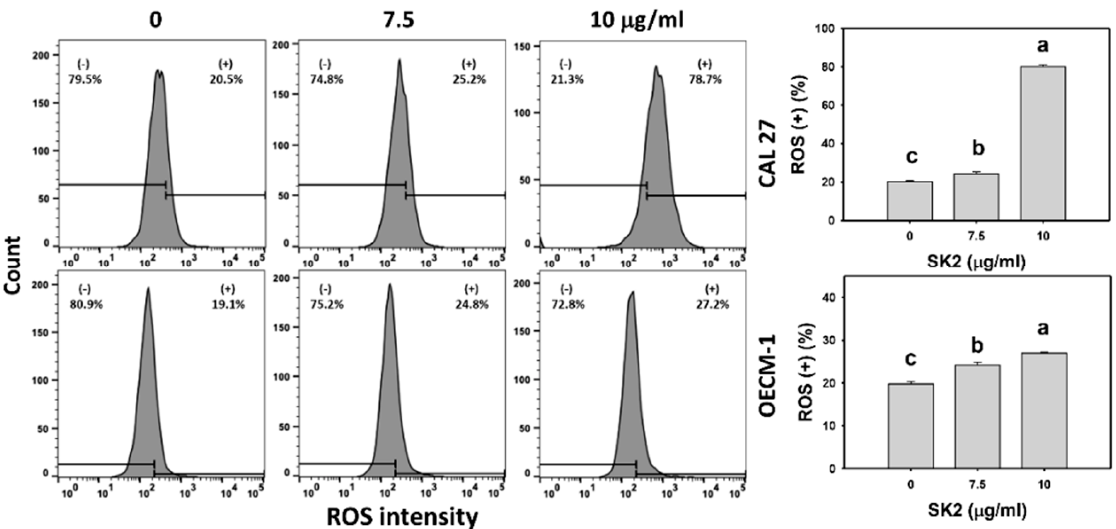
“c, b, and a” indicate significant differences because the data did not overlap.